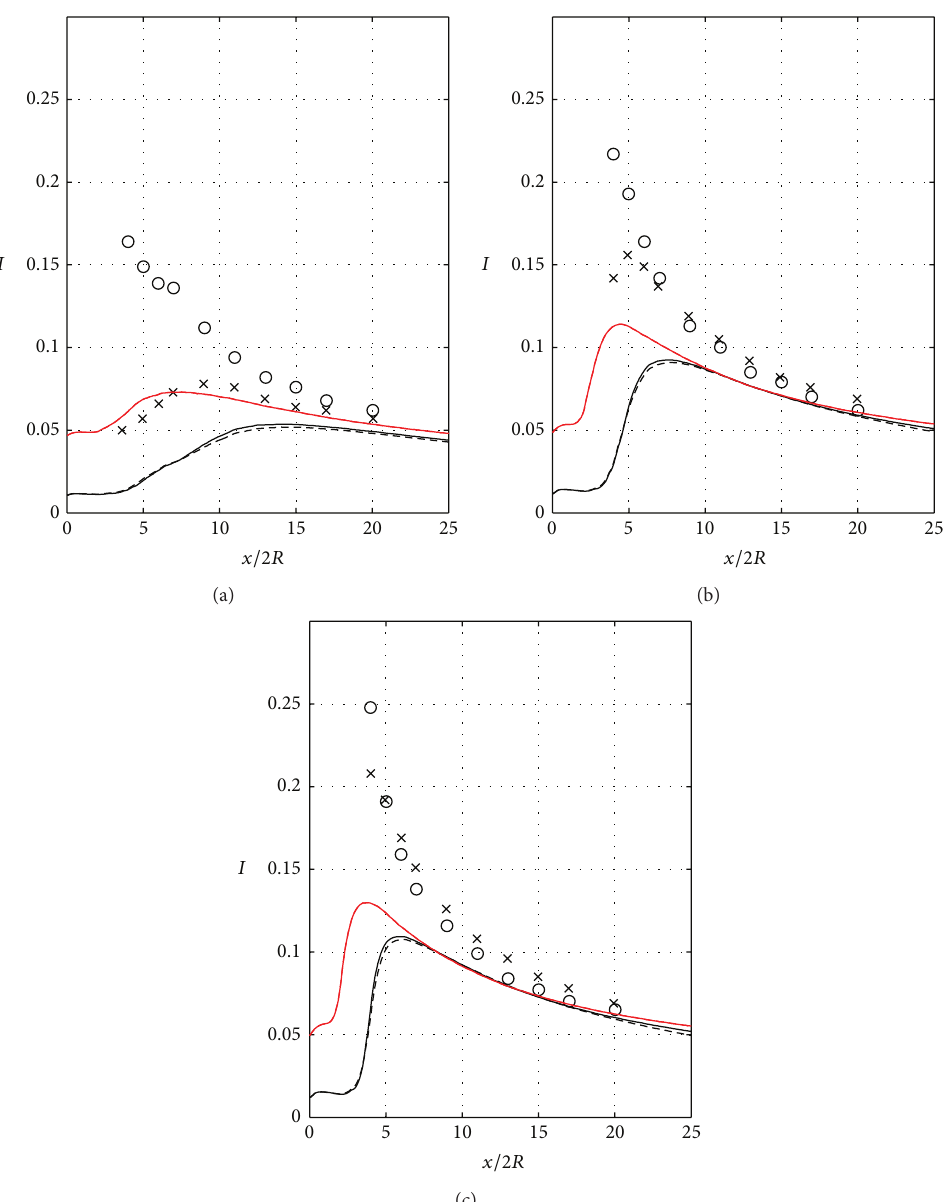
Figure 6: Turbulence intensity along the centre line showing the channel (solid line), duct (dashed line), numerical ( × ) [4], and experimental data ( ⃝ ) [11] for the 𝐶 𝑇 values of (a) 0.61, (b) 0.86, and (c) 0.97 for the experimental study [11]. The inlet 1 simulations are shown in black and inlet 2 simulations are in